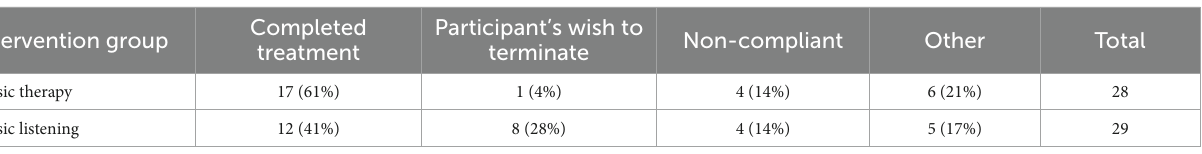
TABLE 1 Completion of treatment.